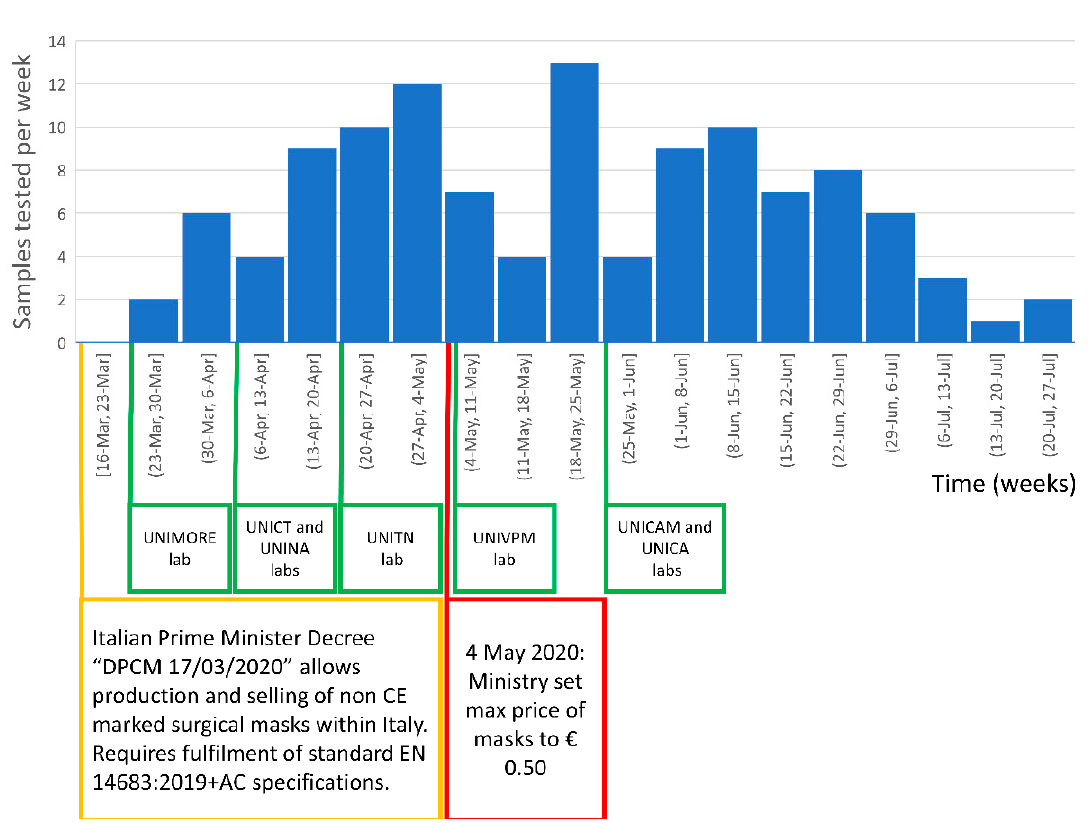
Figure 7. Laboratory response time and workload. Activation of the various university laboratories is indicated in the green boxes. The date of the Decree of the President of the Council of Ministers (DPCM) allowing the import, production and distribution of non-CE marked (conformity with health, safety, and environmental protection standards for products sold within the European Economic Area) surgical masks is indicated in the yellow box. In the red box, the date when the selling price was fixed to EUR 0.50 per mask is given.